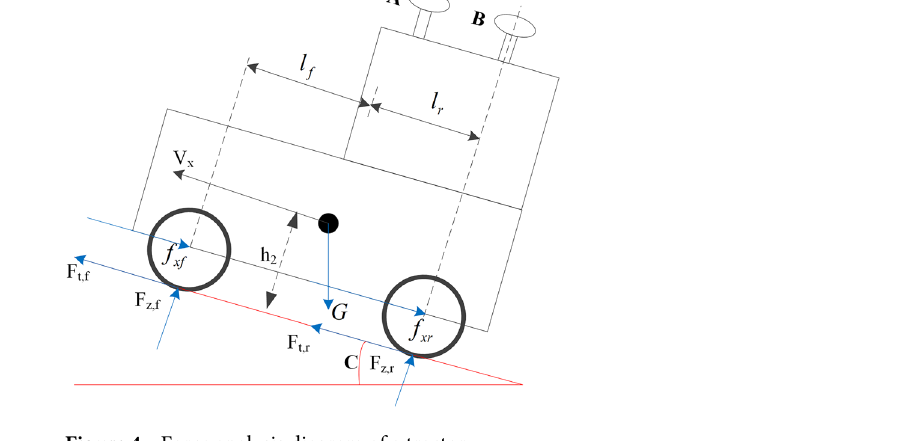
Figure 4. Force analysis diagram of a